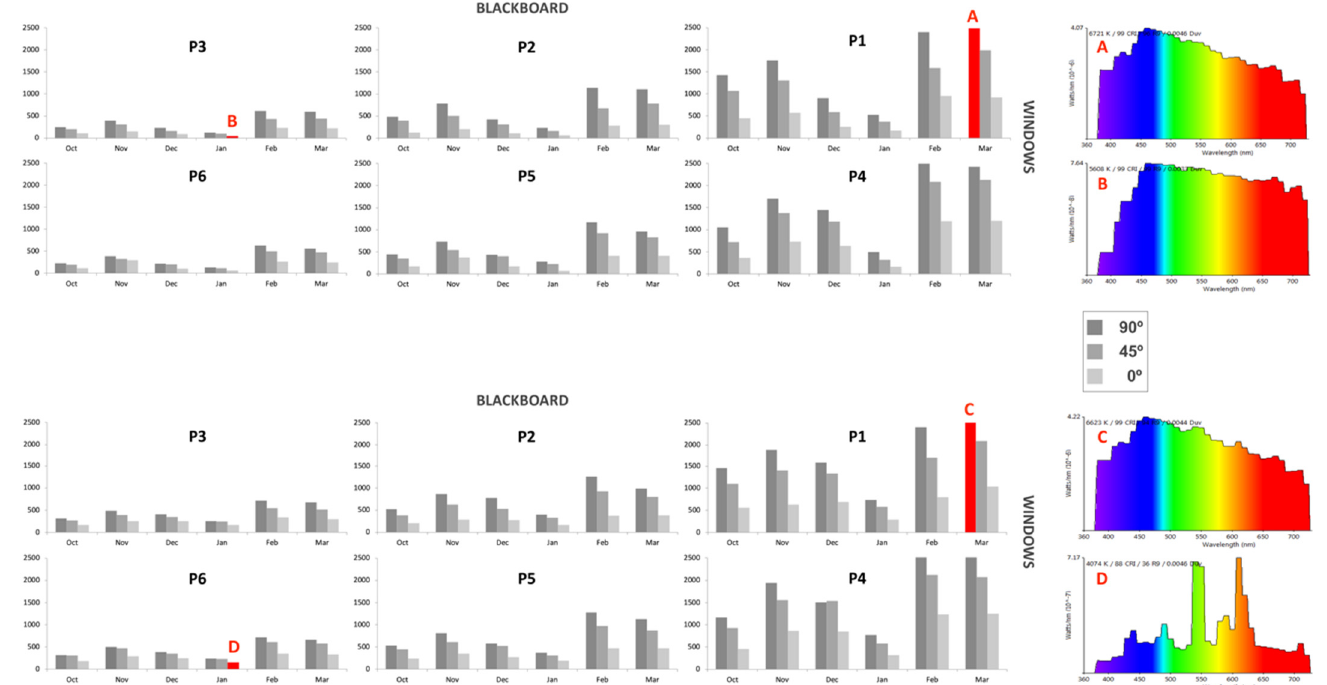
Figure 6. Classroom 3. Melanopic values according to the CIE standard (EDI melanopic lux) acting, in upper figure daylighting in Classroom 3 at each point (P1, P2, P3, P4, P5 and P6) and in the three gaze orientations (0°, 45° and 90°); in lower figure, daylighting + artificial lighting in Classroom 3 at each point (P1, P2, P3, P4, P5 and P6) and in the three gaze orientations (0°, 45° and 90°). Right figures, SPD of ( A ) maximum daylighting in the month of March at Point 1 with 90° orientation; ( B ) minimum daylighting in January at Point 3 with orientation at 0°; ( C ) maximum daylighting + artificial lighting in the month of March at Point 1 with 90° orientation; ( D ) minimum daylighting + artificial lighting in the month of January at Point 6 with orientation at 0°. OsramColorCalculator was used to plot the SPDs.